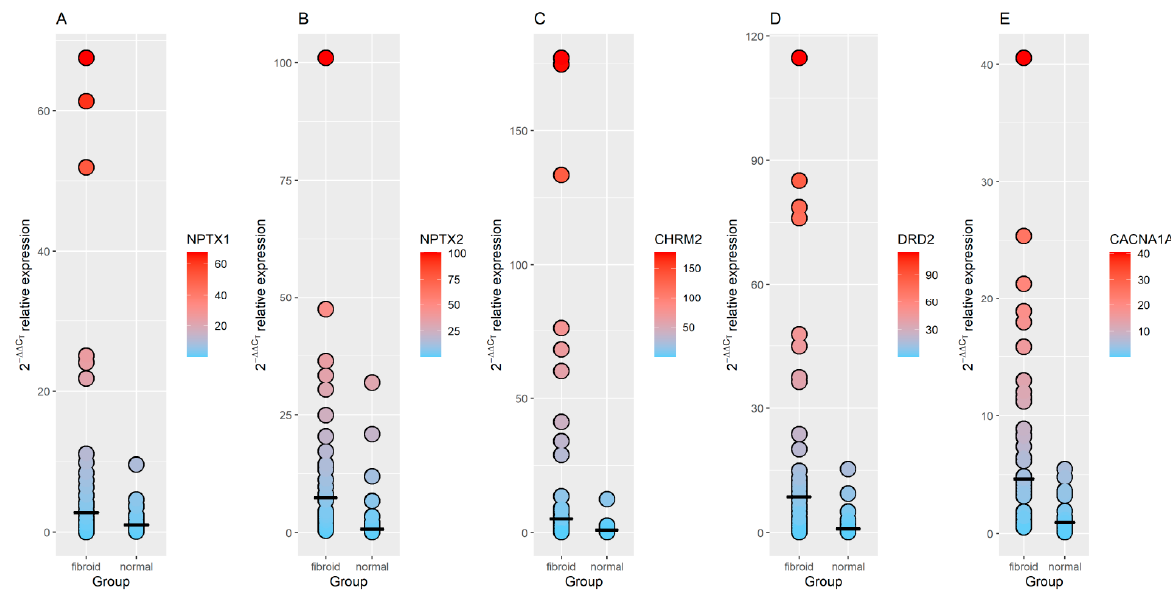
Figure 3. RT-qPCR results of selected genes. A : NPTX1 ; B : NPTX2 ; C : CHRM2 ; D : DRD2 ; E : CACNA1A ; fibroid: fibroid tumor; normal: normal myometrium.